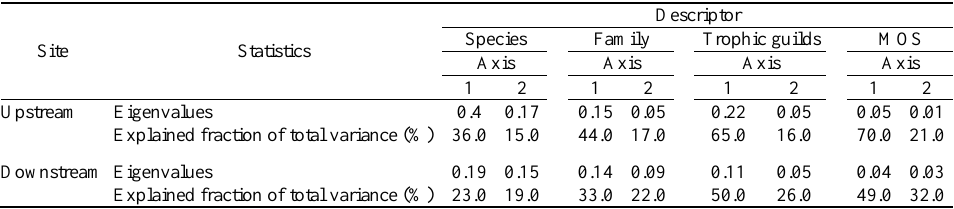
Table 3. Statistics of the Correspondence Analysis (CA) by site and fish assemblage descriptor.